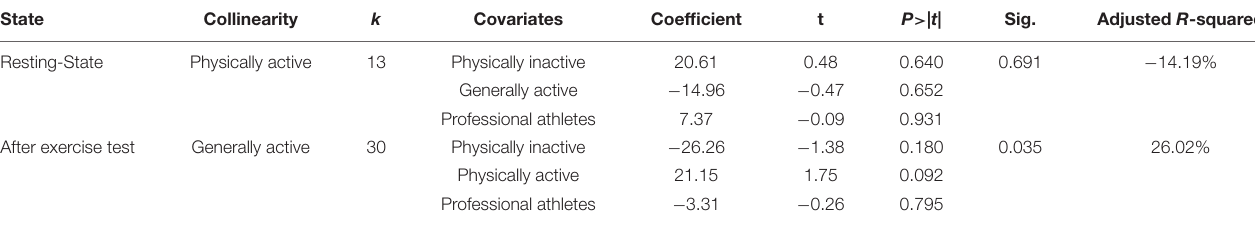
TABLE 7 | The result of Meta-regression between the different populations and the increase of plasma superoxide dismutase (SOD). State Collinearity k Covariates Coefficient t P > | t | Sig. Adjusted R -squared Resting-State Physically active 13 Physically inactive Generally